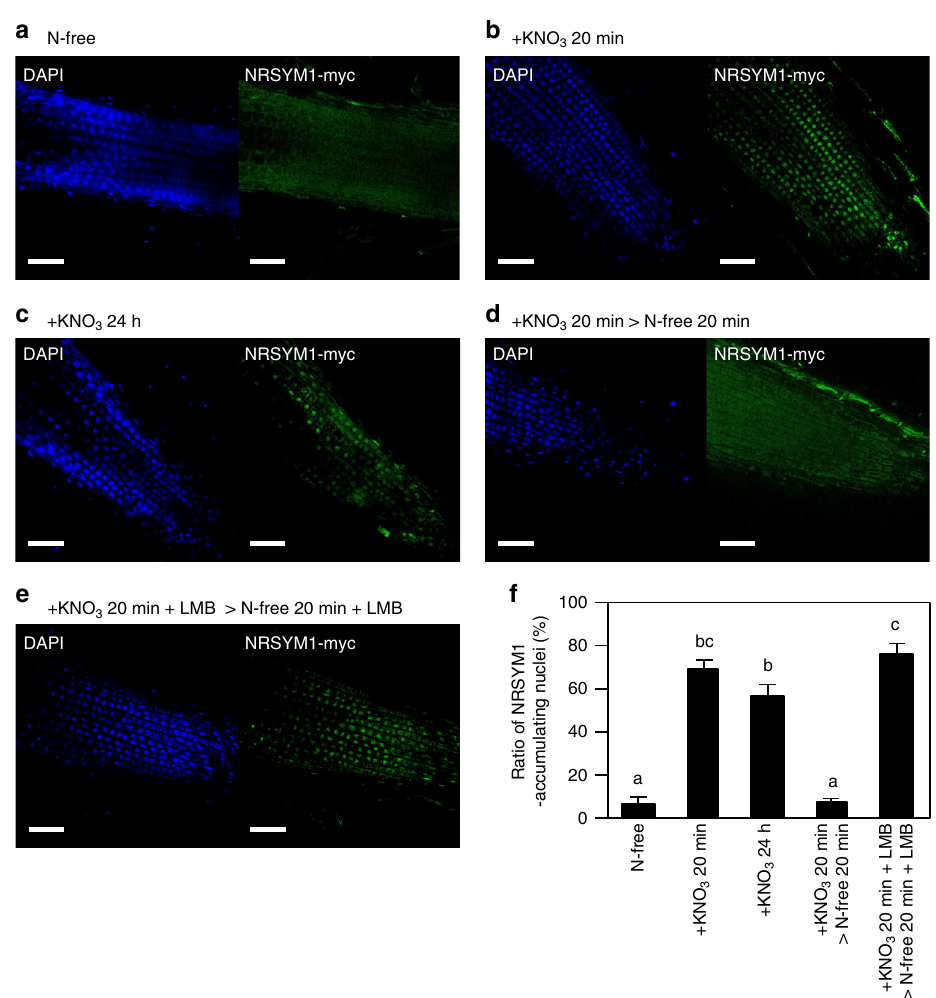
Fig. 8 Subcellular localization of NRSYM1. a – e Immunohistochemistry of the NRSYM1-myc protein in root apical cells. A polyclonal anti-myc antibody and an antibody conjugated to Alexa Fluor 488 (green signal) were used as primary and secondary antibodies. Nuclei were visualized with DAPI (blue signal). Plants with transgenic hairy roots carrying the pLjUBQ:NRSYM1-myc construct were grown in the absence of nitrate for 3 days. N-starved plants were transferred to ( a ) N-free or ( b ) 10 mM KNO 3 medium for 20 min or ( c ) 24 h. d N-starved plants were transferred to 10 mM KNO 3 medium for 20 min, and then to N-free medium for 20 min. e N-starved plants were fi rst incubated with leptomycin B (LMB) in a N-free medium for 3 h, and then transferred to 10 mM KNO 3 medium with LMB for 20 min and to N-free medium with LMB for 20 min. Scale bars: 50 μ m. f The ratio of NRSYM1-accumulating nuclei. Using respective fl uorescent images, the percentages of nuclei having green signals among all DAPI-stained nuclei were calculated. Error bars indicate SEM ( n = 5 roots). Columns with the same lower-case letter indicate no signi fi cant difference (Tukey ’ s test, P <